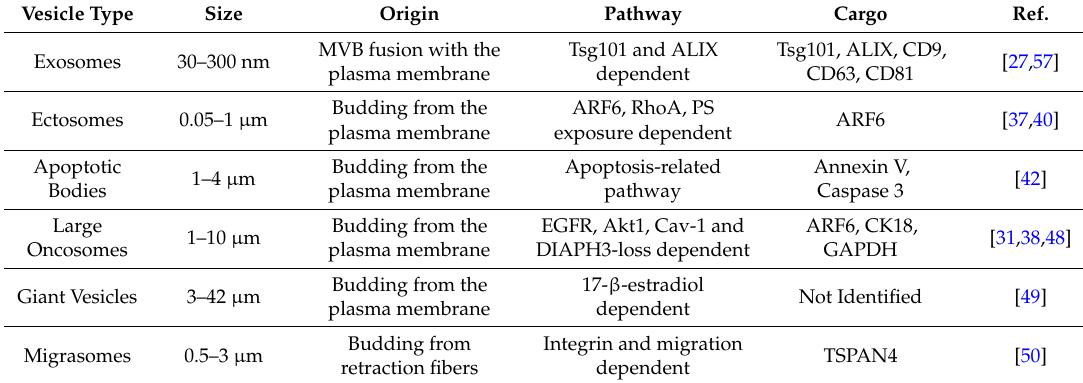
Table 1. Populations of Extracellular